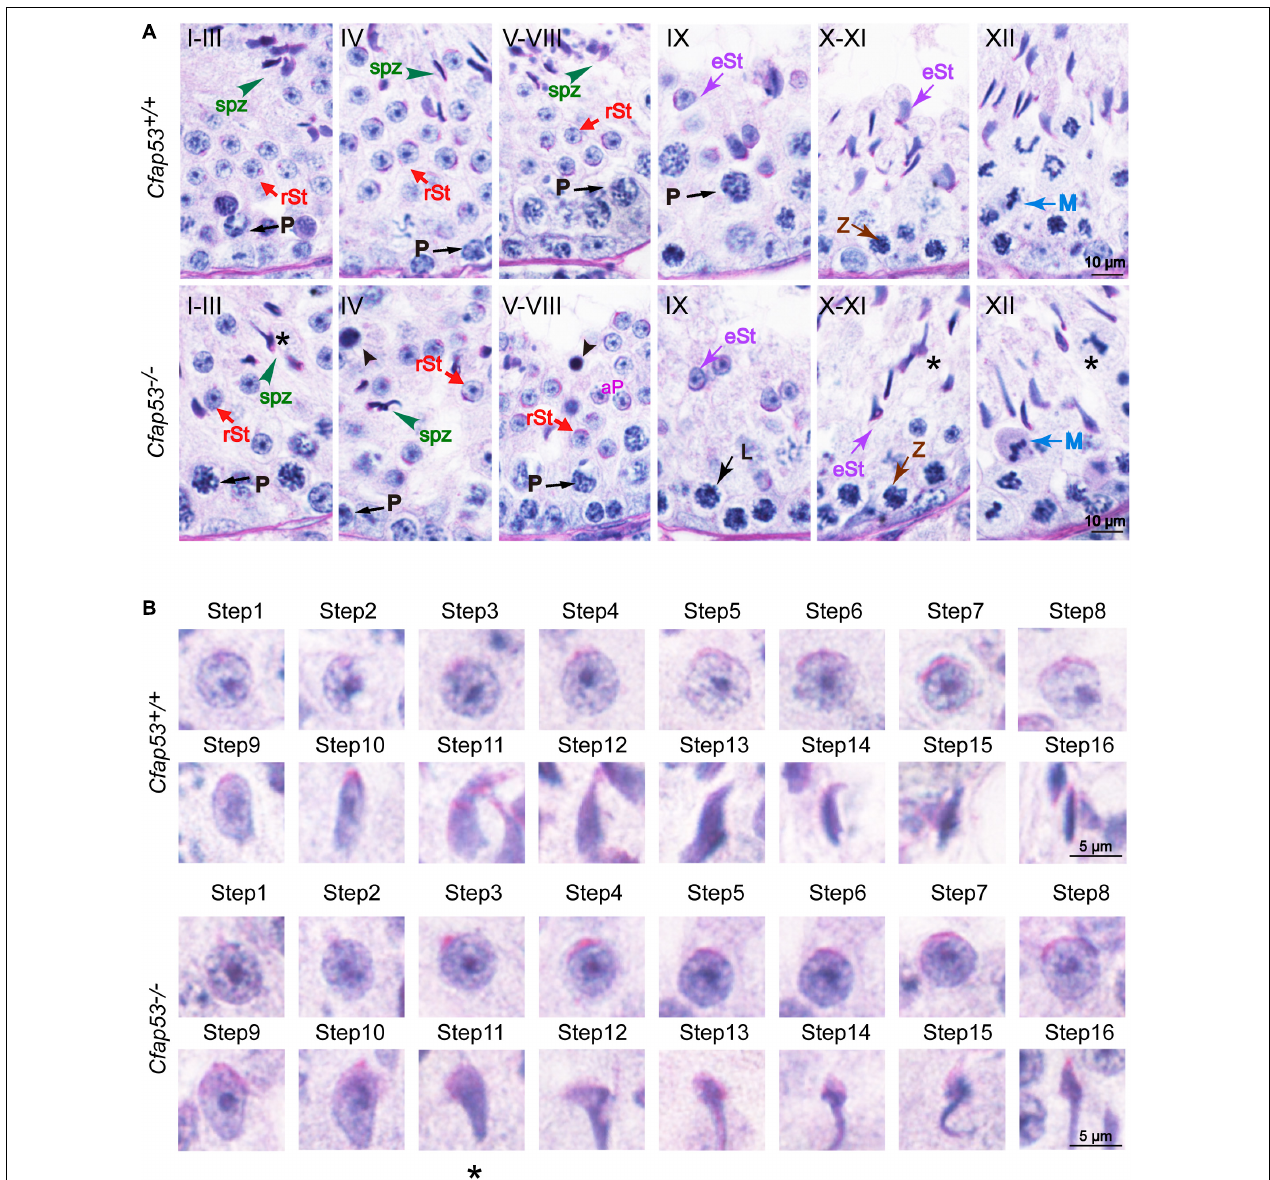
FIGURE 3 | Spermatogenesis defects of Cfap53 − / − mice. (A) PAS staining of testes sections from Cfap53 + / + and Cfap53 − / − mice. Defects in the nuclear shape of several elongating spermatids were clearly evident in the Cfap53 − / − seminiferous tubule (asterisks). Apoptotic bodies were detected in Cfap53 − / − testes sections (black arrowheads). P: pachytene spermatocyte, L: leptotene spermatocyte, Z: zygotene spermatocyte, M: meiotic spermatocyte, rST: round spermatid, eST: elongating spermatid, spz: spermatozoa. (B) The PAS staining of spermatids at different steps from Cfap53 + / + and Cfap53 − / − mice. From step 1 to step 10 spermatids, the head morphology was roughly normal in Cfap53 − / − mice. Abnormal, club-shaped heads (asterisk) were first seen in step 11 spermatids in Cfap53 − / −